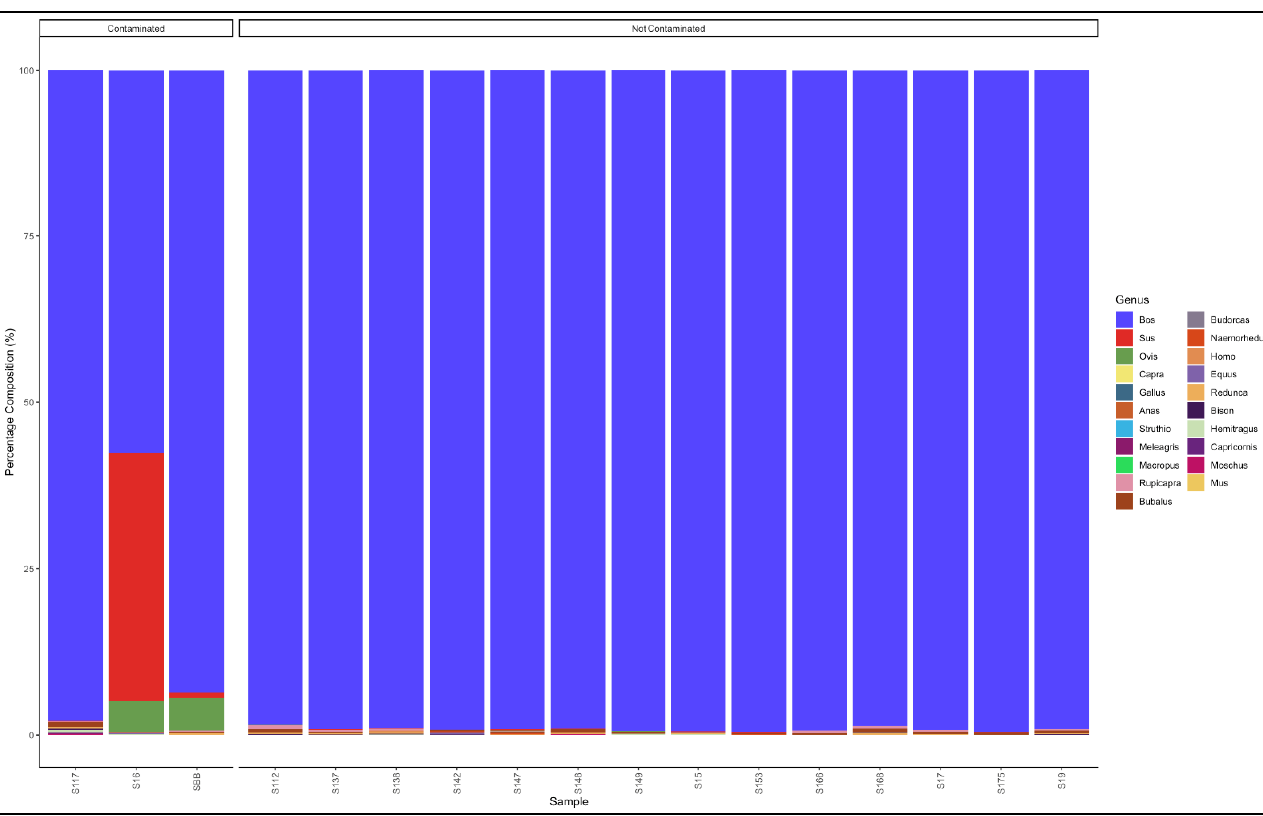
Figure 5. Percentage composition of samples labeled as beef biltong.